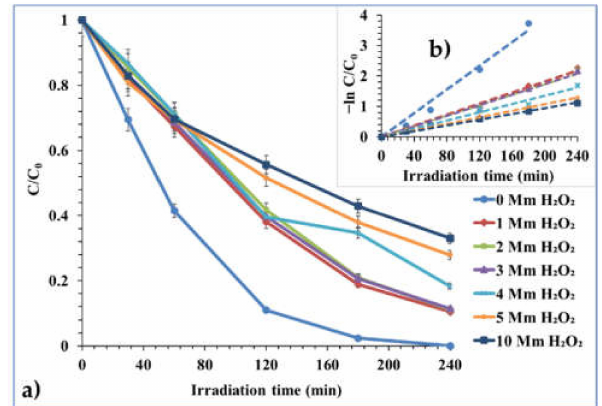
Figure 16. ( a ) H 2 O 2 effect on the photocatalytic degradation performance of 1 g/L Mo/SynTiO 2 over 5 mg/L initial CBZ concentration under natural (unmodified) pH 5.84 and 365 nm irradiation; and ( b ) their corresponding photocatalytic degradation rate constant (k).